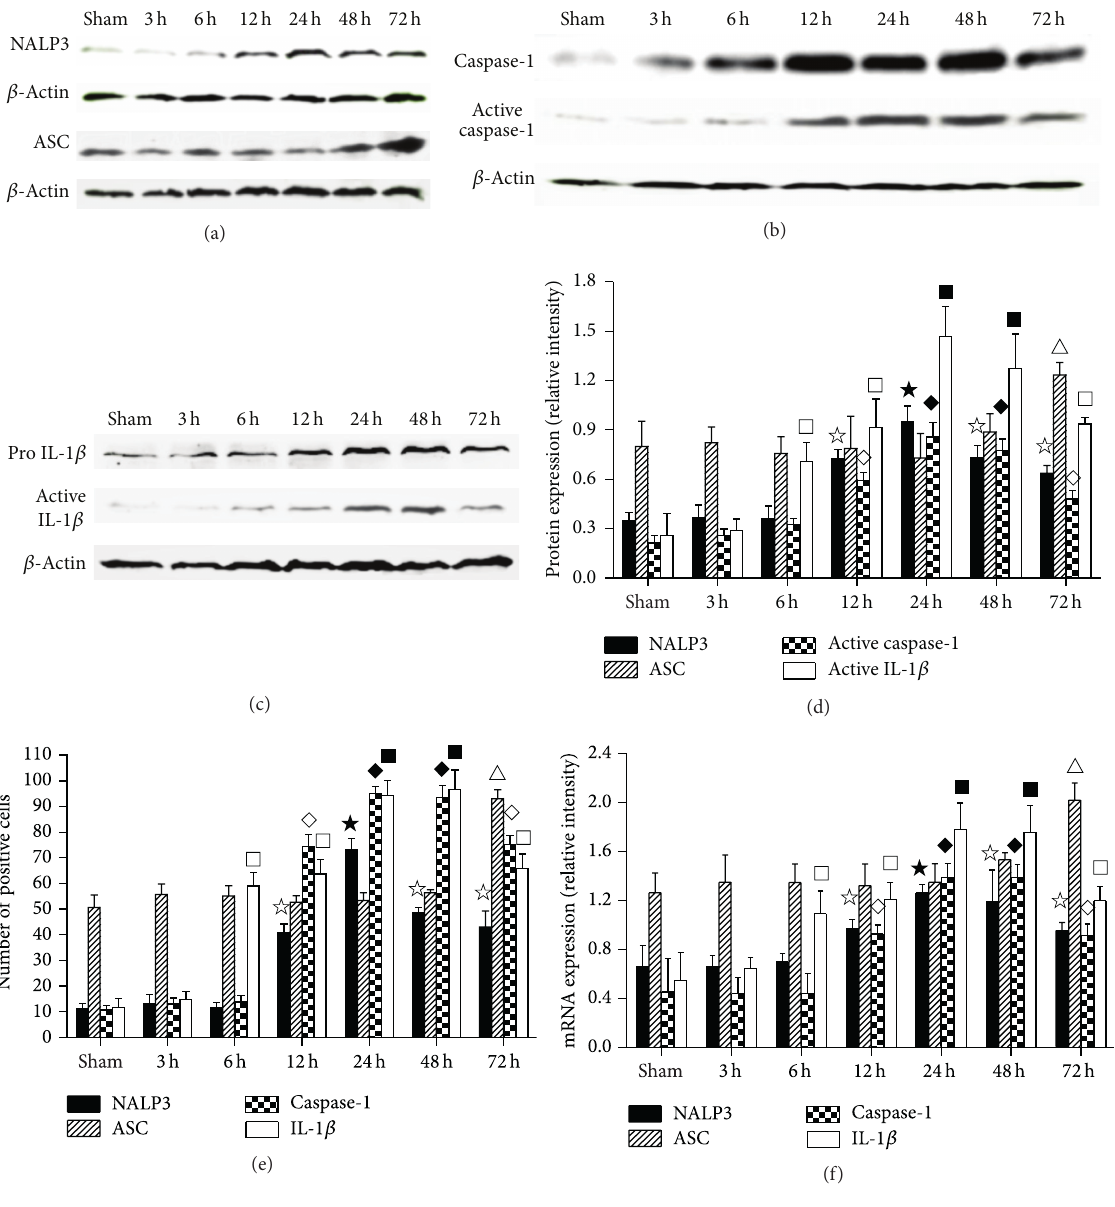
Figure 4: The dynamic expression of NALP3 inflammasome and IL-1 𝛽 during the natural inflammatory response induced by tMCAO. Western blot of dynamic expression ((a), (b), (c)). Bar graph illustrating the dynamic expression of NALP3, ASC, active caspase-1, and active IL-1 𝛽 in brain tissues (d). Bar graph illustrating dynamic expression of NALP3, ASC, caspase-1, and IL-1 𝛽 as determined by immunohistochemistry (e). Bar graph illustrating the mRNA dynamic expression of NALP3, ASC, caspase-1, and IL-1 𝛽 (f). For NALP3, f 𝑃 < 0.05 versus Sham, 󳀅 𝑃 < 0.05 versus Sham, 3h, 6 h, 12h, 48 h, and 72 h. For ASC, △ 𝑃 < 0.05 versus Sham. For active caspase-1 and active IL-1 𝛽 , ◊ 𝑃 < 0.05 and ◻ 𝑃 < 0.05 versus Sham, ⧫ 𝑃 < 0.05 and ◼ 𝑃 < 0.05 versus Sham, 3h, 6h, 12 h, and 72